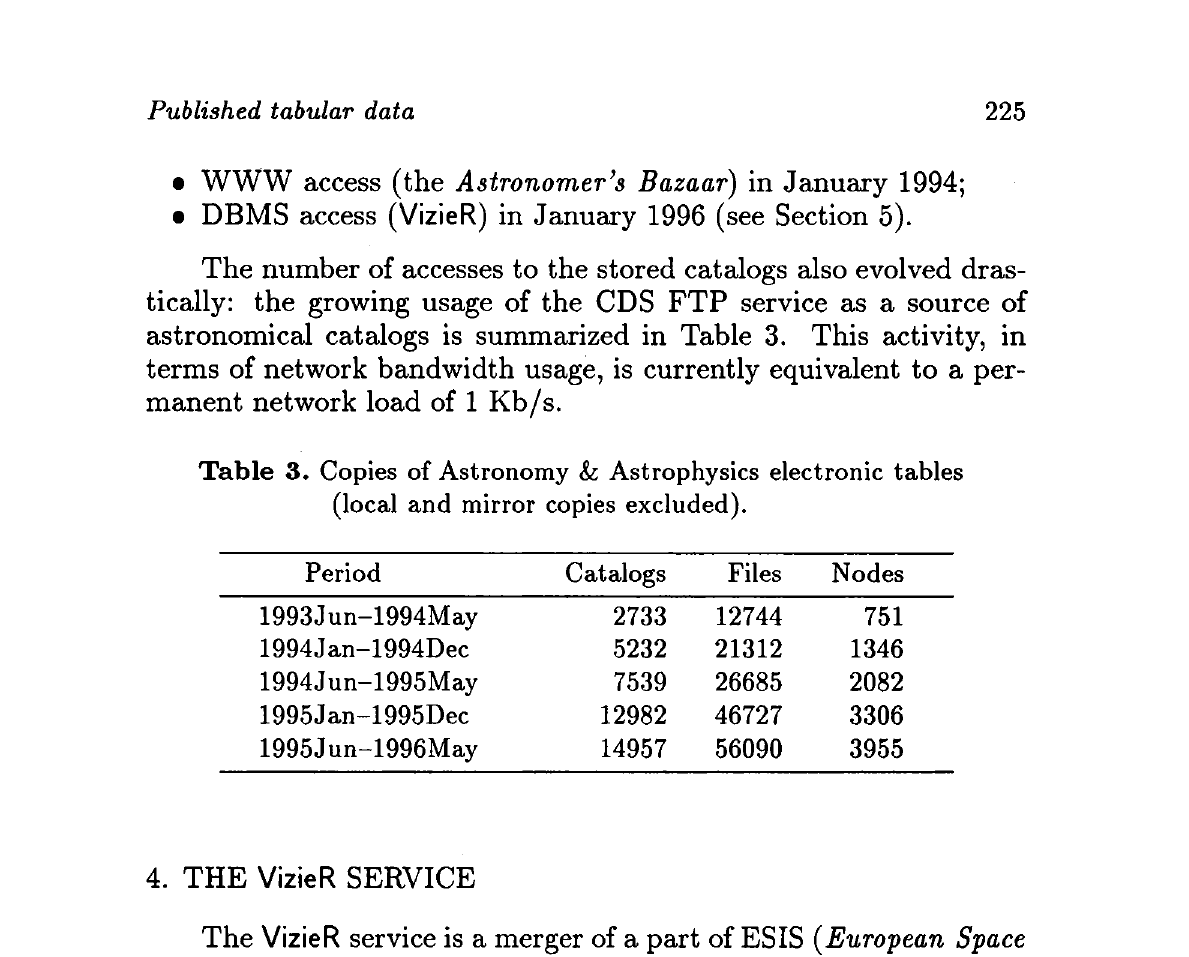
Table 3. Copies of Astronomy L· Astrophysics electronic tables (local and mirror copies